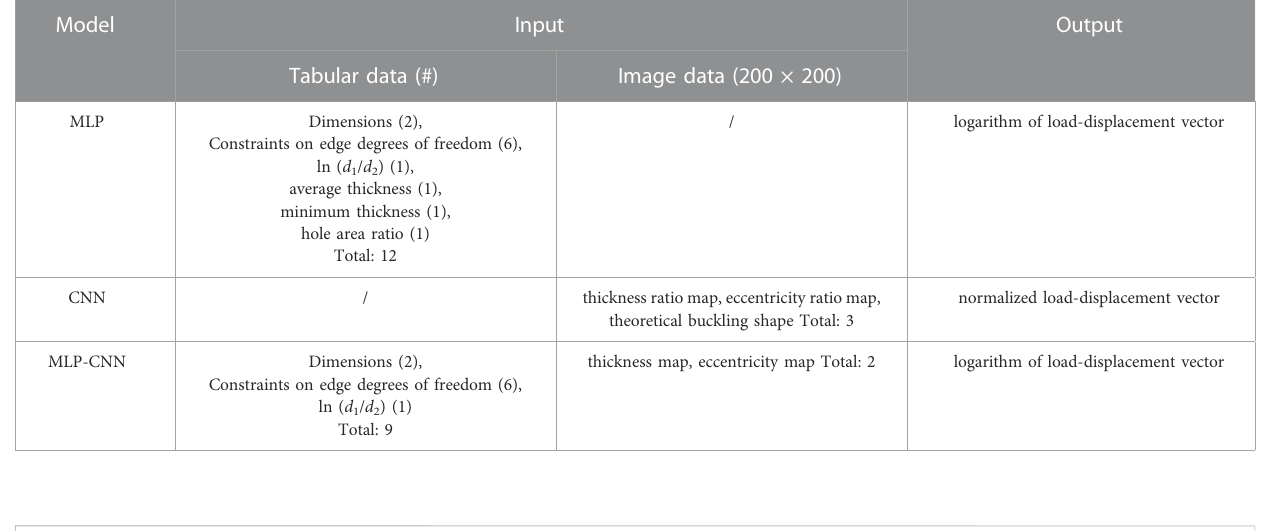
TABLE 3 Input and output of neural network models.